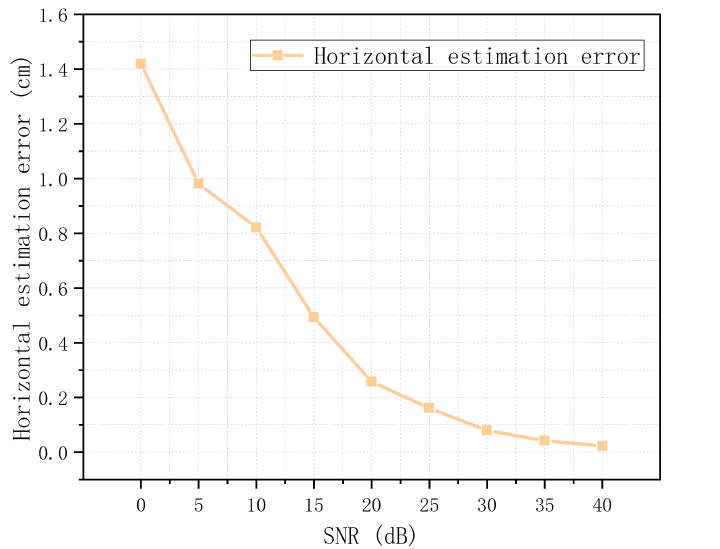
Figure 8. Estimation error of the horizontal position of the cylindrical target at different signal-to-noise ratio (SNR)